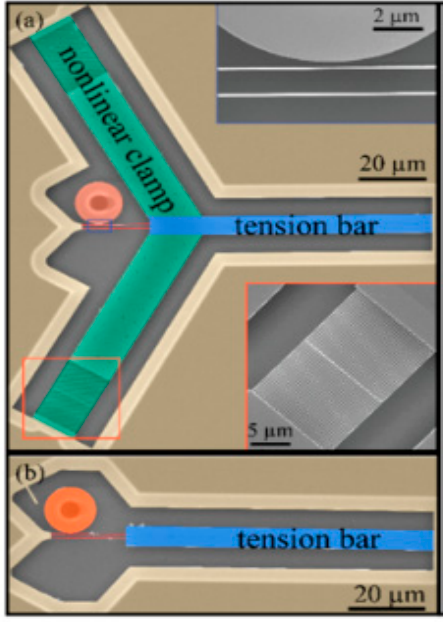
Figure 11. Tuning forks with temperature compensation ( a ) and without temperature compensation ( b ), top inset: coupling of optical readout resonator with tuning fork nanobeam, bottom inset: straightened nonlinear springs. Adapted with permission from [116].